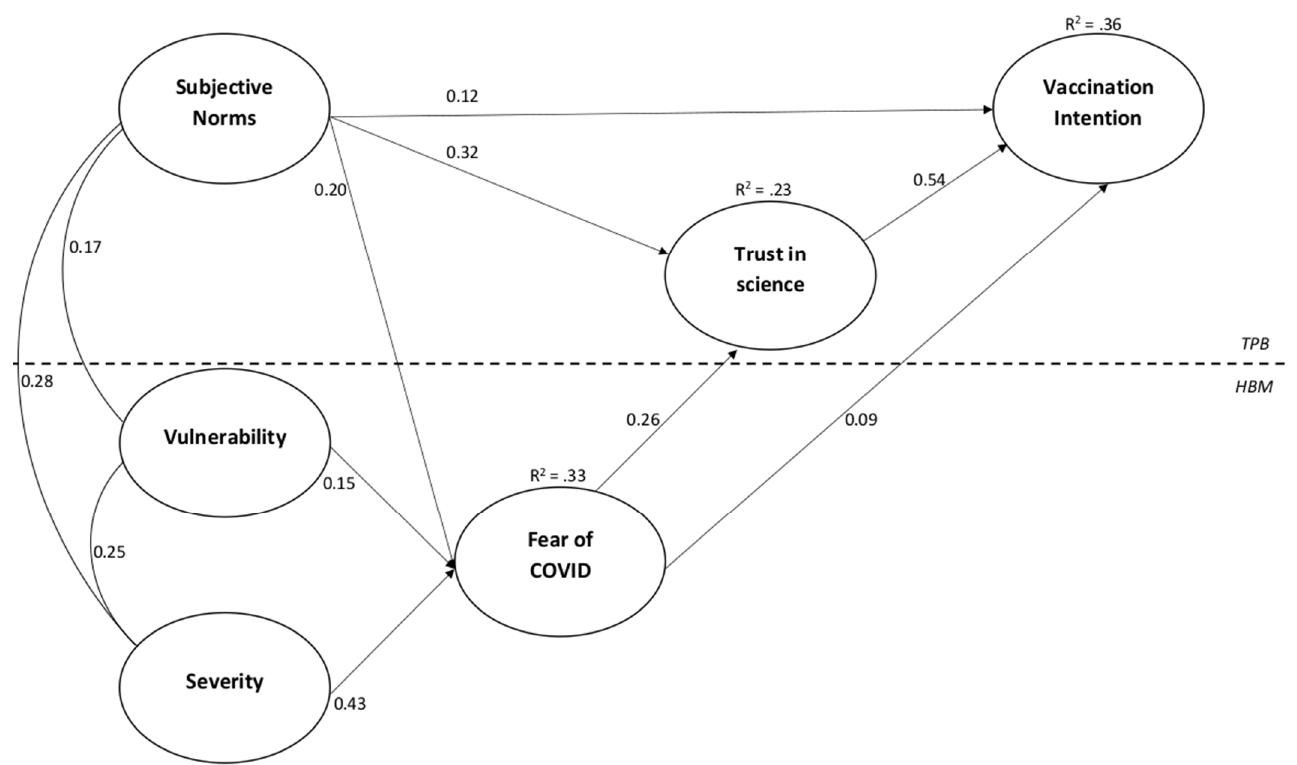
Figure 3. Path diagram of the tested